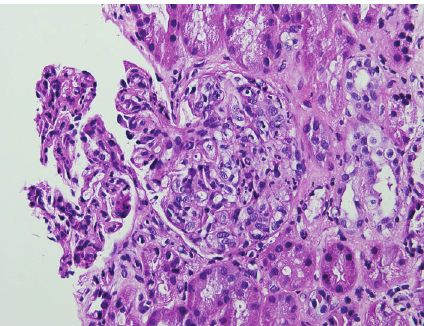
Figure 1: H & E stain of renal biopsy: Light micrograph suggestive of membranoproliferative glomerulonephritis showing hypercellu- lar glomeruli with prominence of mesangial matrix.